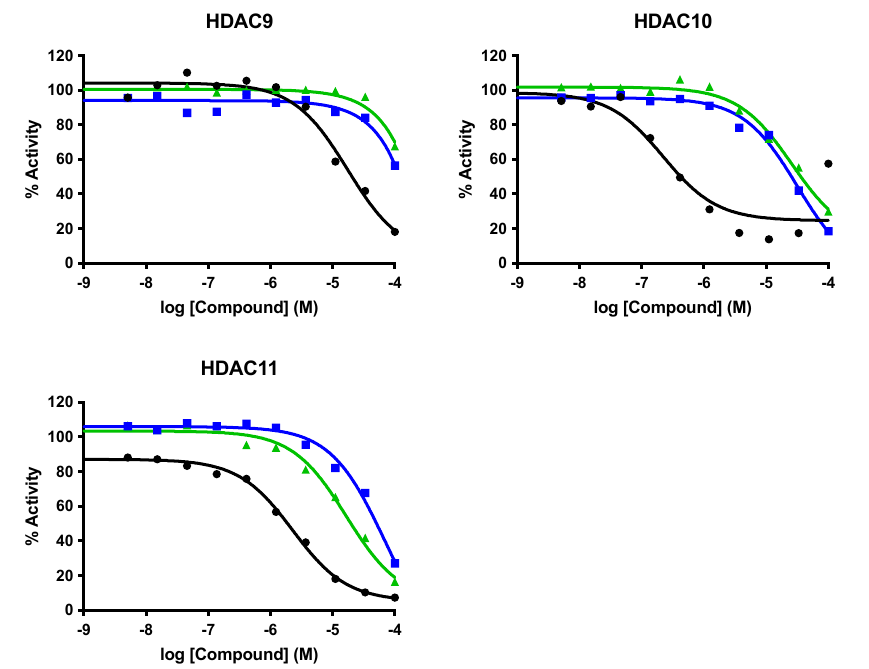
Figure 3. HDAC inhibitory activity of Scriptaid analogs. Black = 7 ; blue = 8 ; green = 9 .